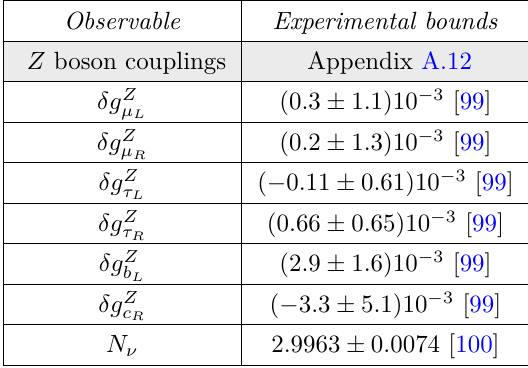
Table 3 . Limits on the deviations in Z boson couplings to fermions from LEP